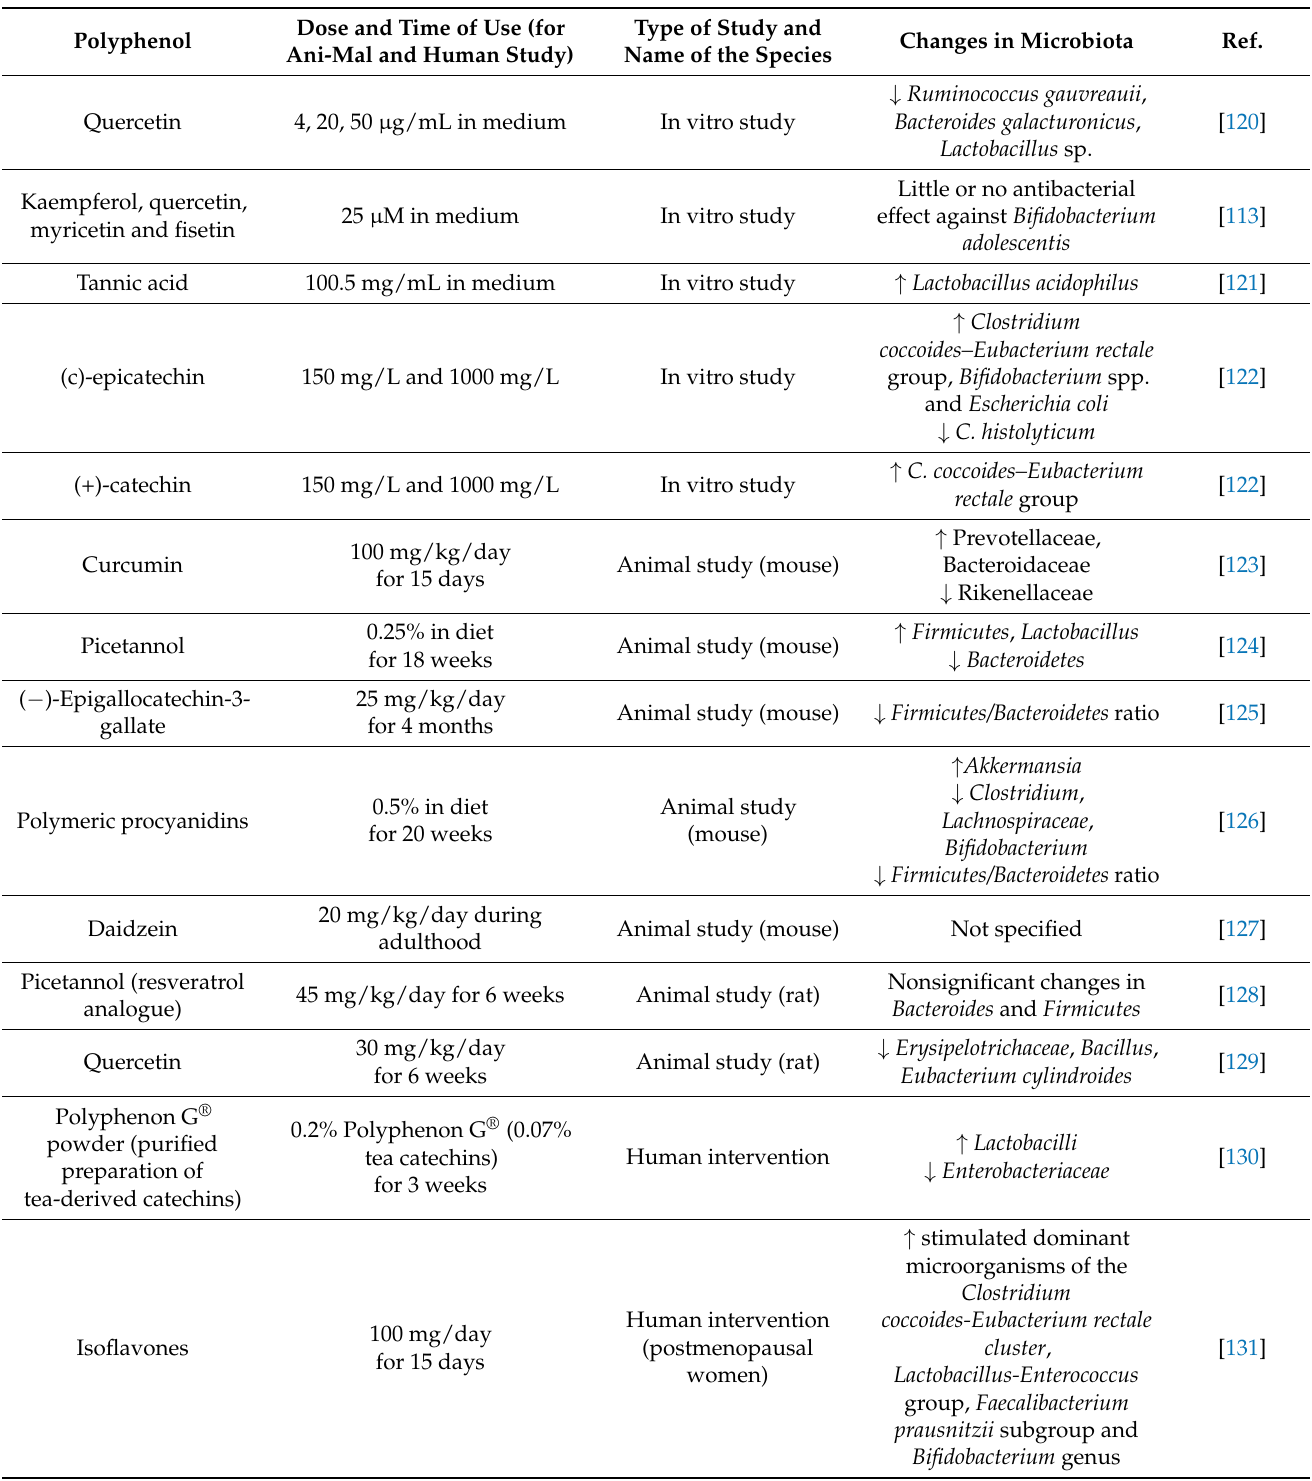
Table 1. Effects of polyphenols on gut microbiota